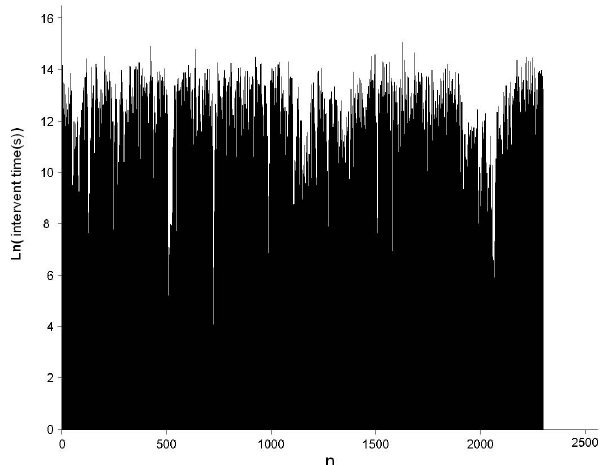
Fig. 2. The interevent interval time series of the seismicity shown in Fig. 1 with logarithmic scale.